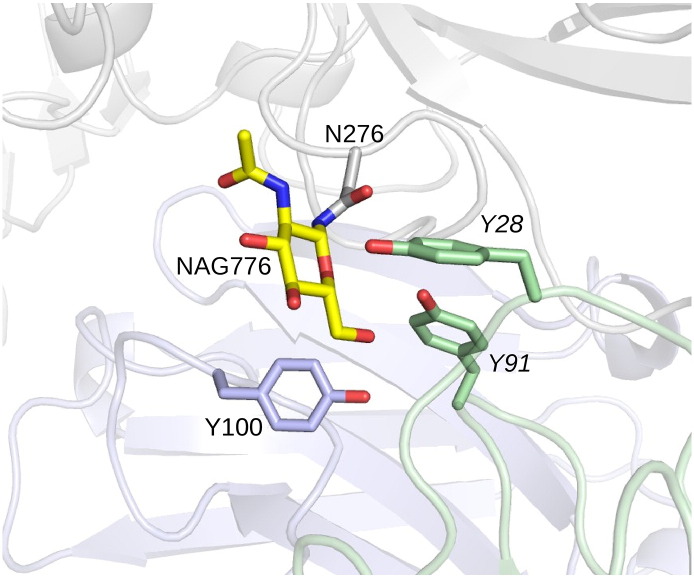
The glycan fragment on gp120 residue N276 captured in the 3NGB crystal structure, N776, is shown with the three cases identified as suspected glycan contacts (Y104, Y91, and Y104).